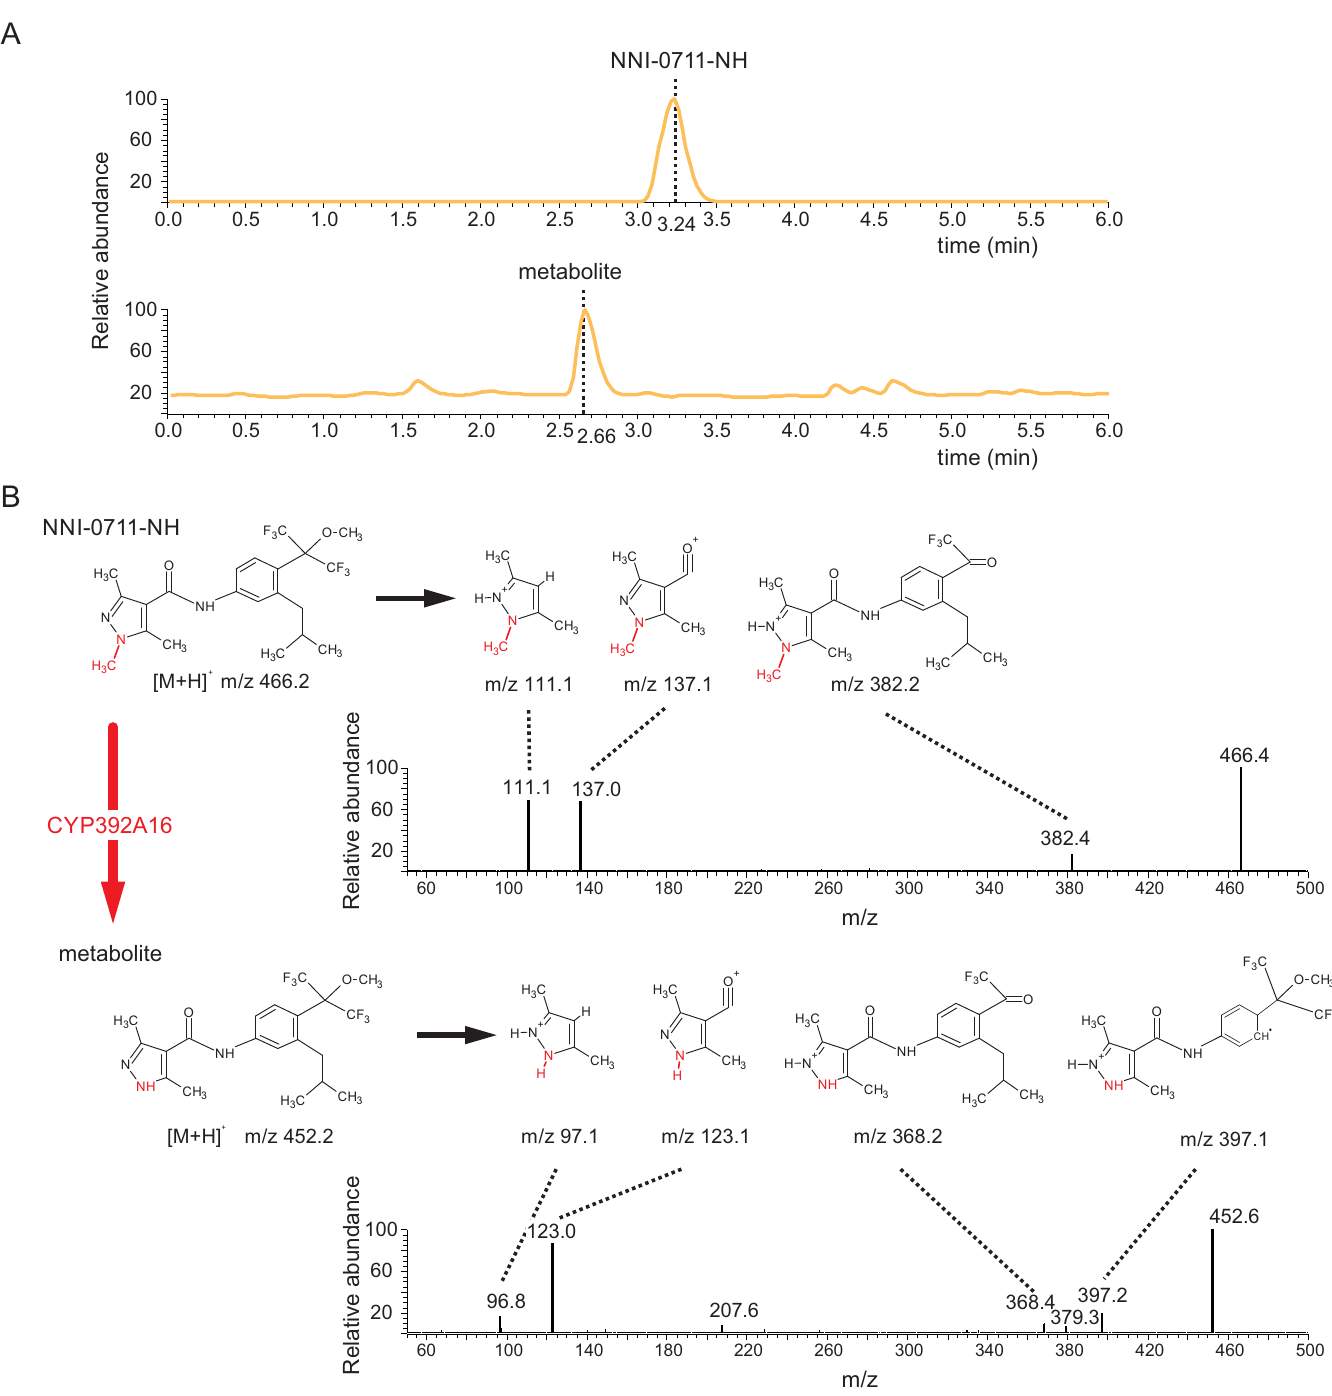
Fig 7. The toxic pyflubumide metabolite NNI-0711-NH is demethylated by CYP392A16. (A) Total ion chromatograms and product ion mass spectra obtained from the collision induced dissociation of NNI-0711-NH and the reaction metabolite molecular ions (m/z 466 and m/z 452 respectively) as obtained following their HPLC separation. TIC values for NNI-0711-NH and the reaction metabolite were 5.01E 5 and 1.07E 4 , respectively. (B) Proposed product ions for NNI-0711-NH (m/z 466) and the reaction metabolite (m/z 452). Demethylation, which is expected to proceed via hydroxylation, results in a mass difference of -14 Da between NNI-0711-NH and the metabolite. The proposed demethylation site is indicated by red font. This scenario was confirmed in almost all product ions formed by collision induced dissociation.